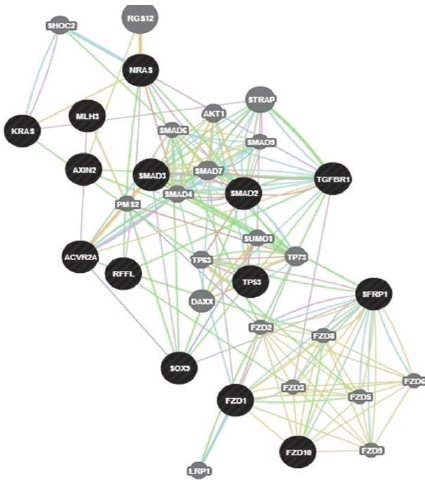
Figure 6: This network was derived from the GeneMania tool from genemania.org. It creates a network between the genes that were found to be underexpressed. The blue lines represent the various pathways connecting our genes of interest, which are in turn shaded in black. Gray spheres are genes that are not queried genes but are predicted to be related.